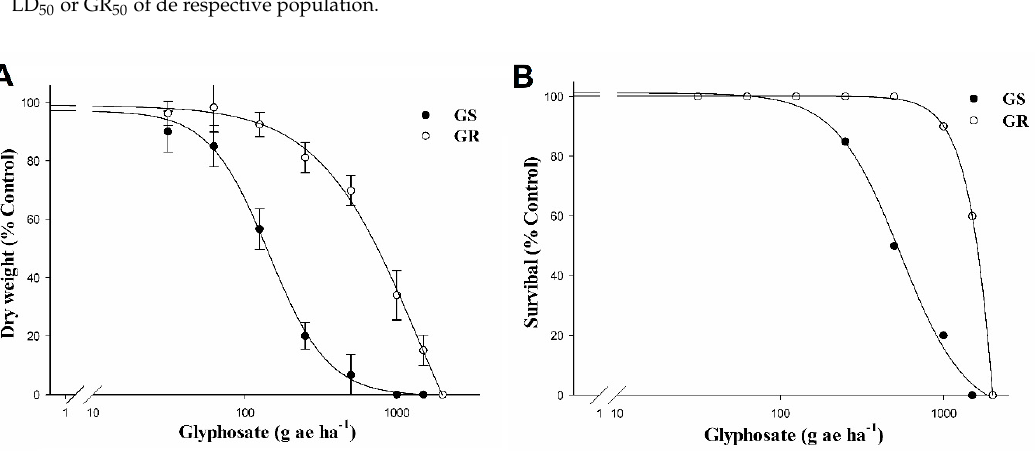
a d is upper limits of the curve; b is the slope at the inflection point (i.e., GR the means; P is the level of significance of the non-linear model, and RF, resistance factor (GR / GS) calculated using LD 50 or GR 50 of de respective population.